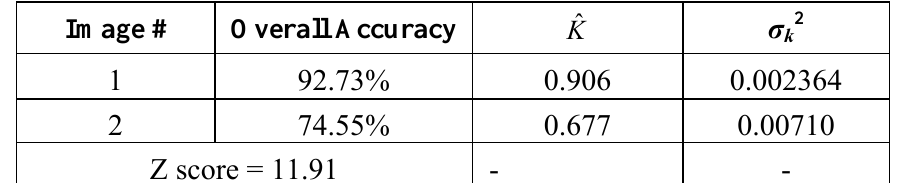
Table 2C. Accuracy assessment for the classification results in tables 2A and 2B.